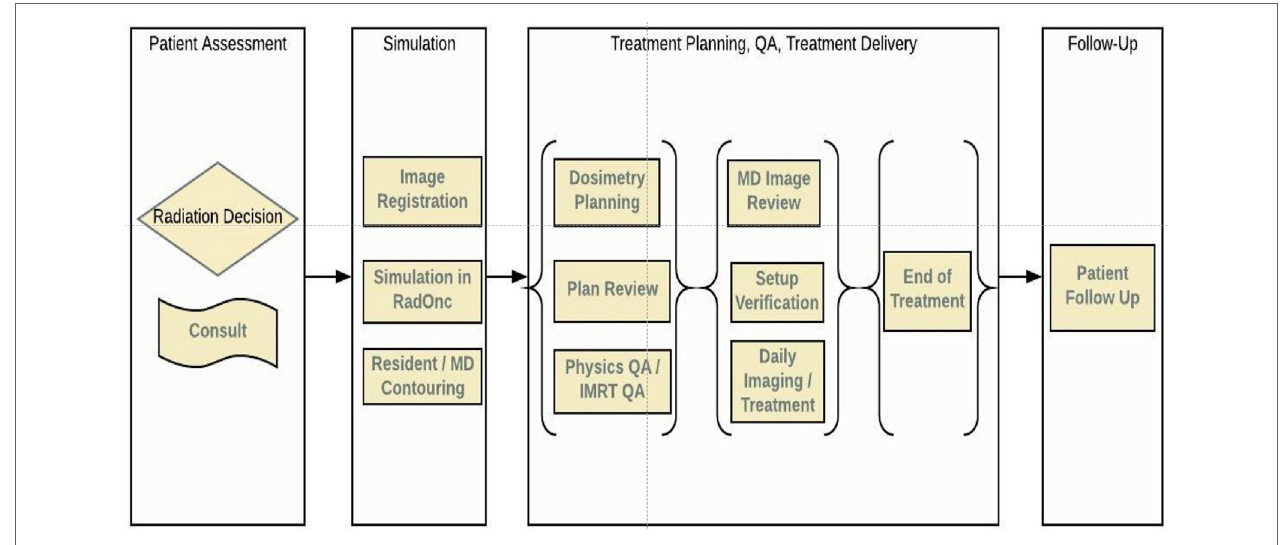
FigUre 1 | Radiotherapy workflow, from consult to